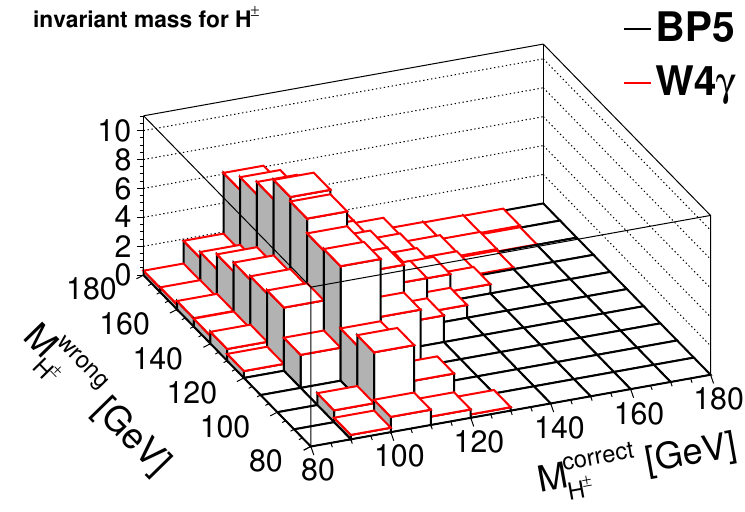
Figure 1 . The 3D M γγ distribution for the two γγ pairings of the BP5 signal.